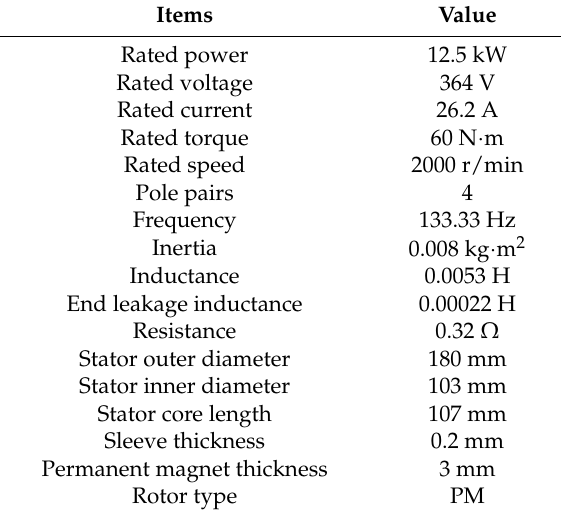
Table 1. Parameters of the permanent magnet synchronous motor (PMSM).